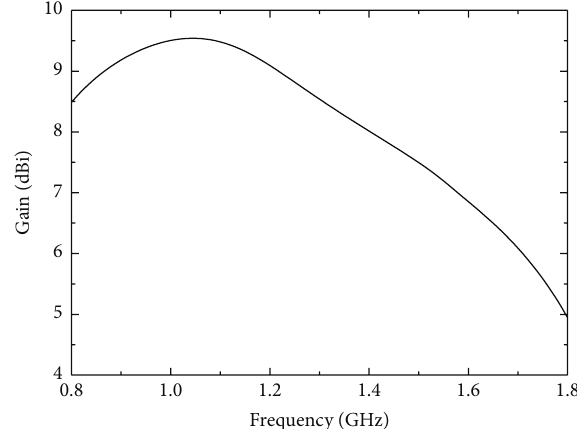
Figure 12: Gain versus frequency for a dual-feed circularly polarization.